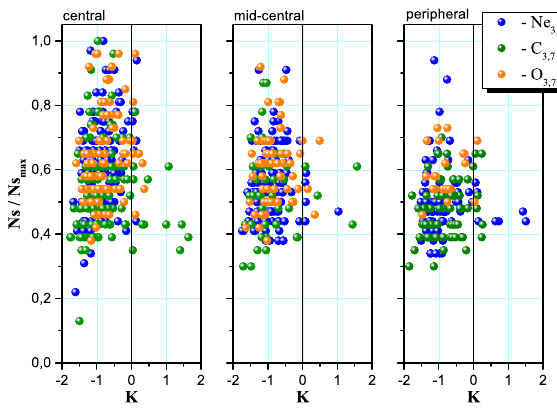
Figure 6. E-by-E Kurtosis (K) analysis for (C, O, Ne) + (C / N / O)